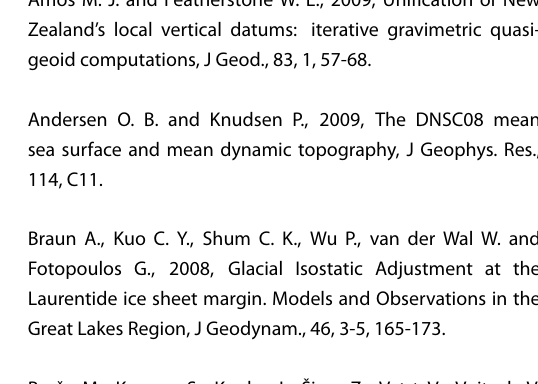
0 values and their precisions